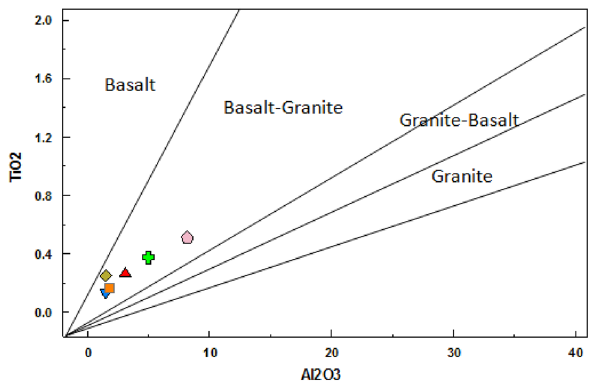
Fig. 4 Provenance diagram of Al 2 O 3 versus TiO 2 in coal (after Amajor 1987)